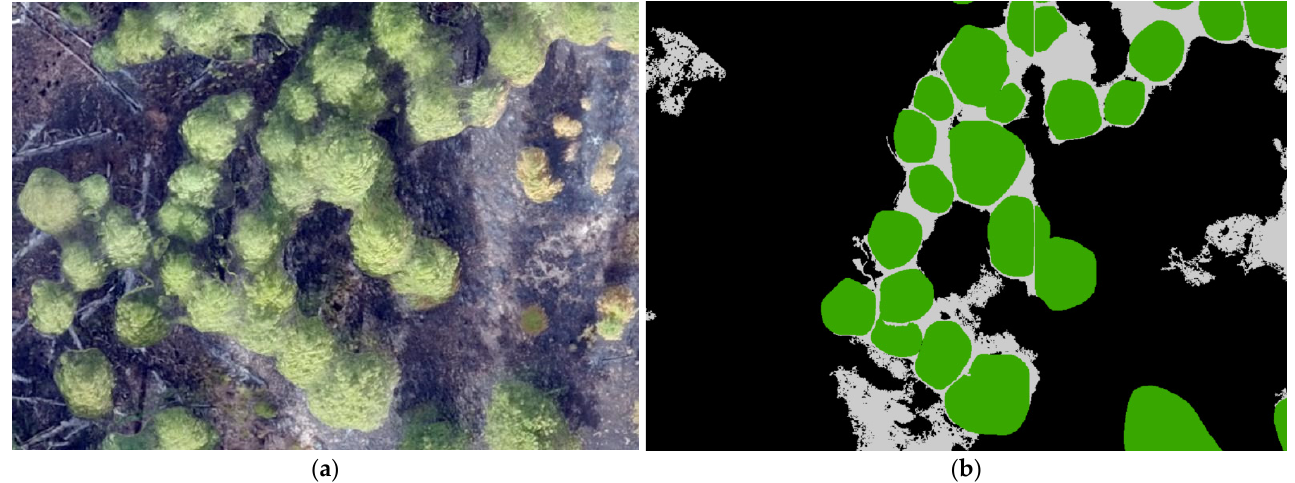
Figure 10. ( a ) Part of the Cottonwood fire where the trees are clearly burned underneath. ( b ) The same part of the Cottonwood fire with the Sub-Canopy Burn Mapping Tools output overlaid. It can be seen that a large section of trees in the middle of the image are not removed due to a large group of noise surface pixels surrounding them.